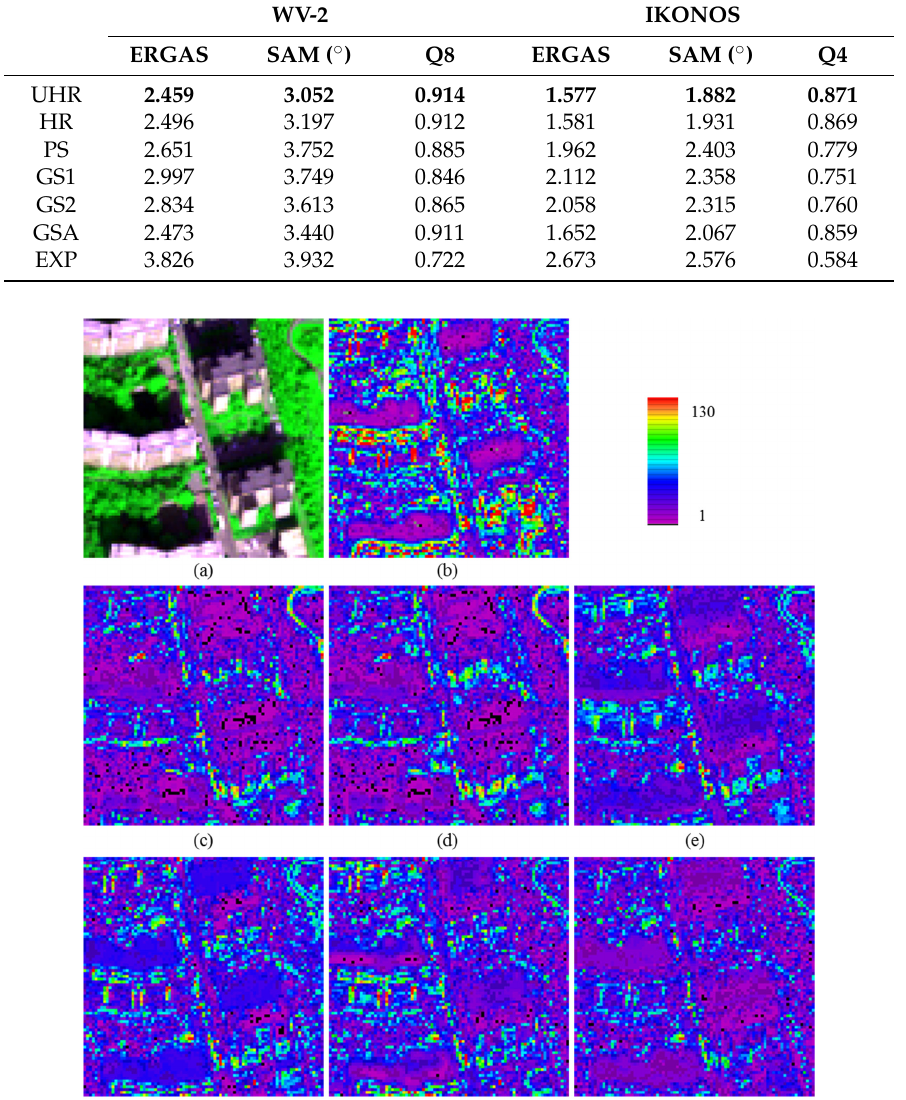
Table 1. Values of the comprehensive quality indices of the fused images produced from the degraded WV-2 and IKONOS datasets. Q, Quality; UHR, un-mixed haze- and ratio-based (HR); PS, PANSHARP.